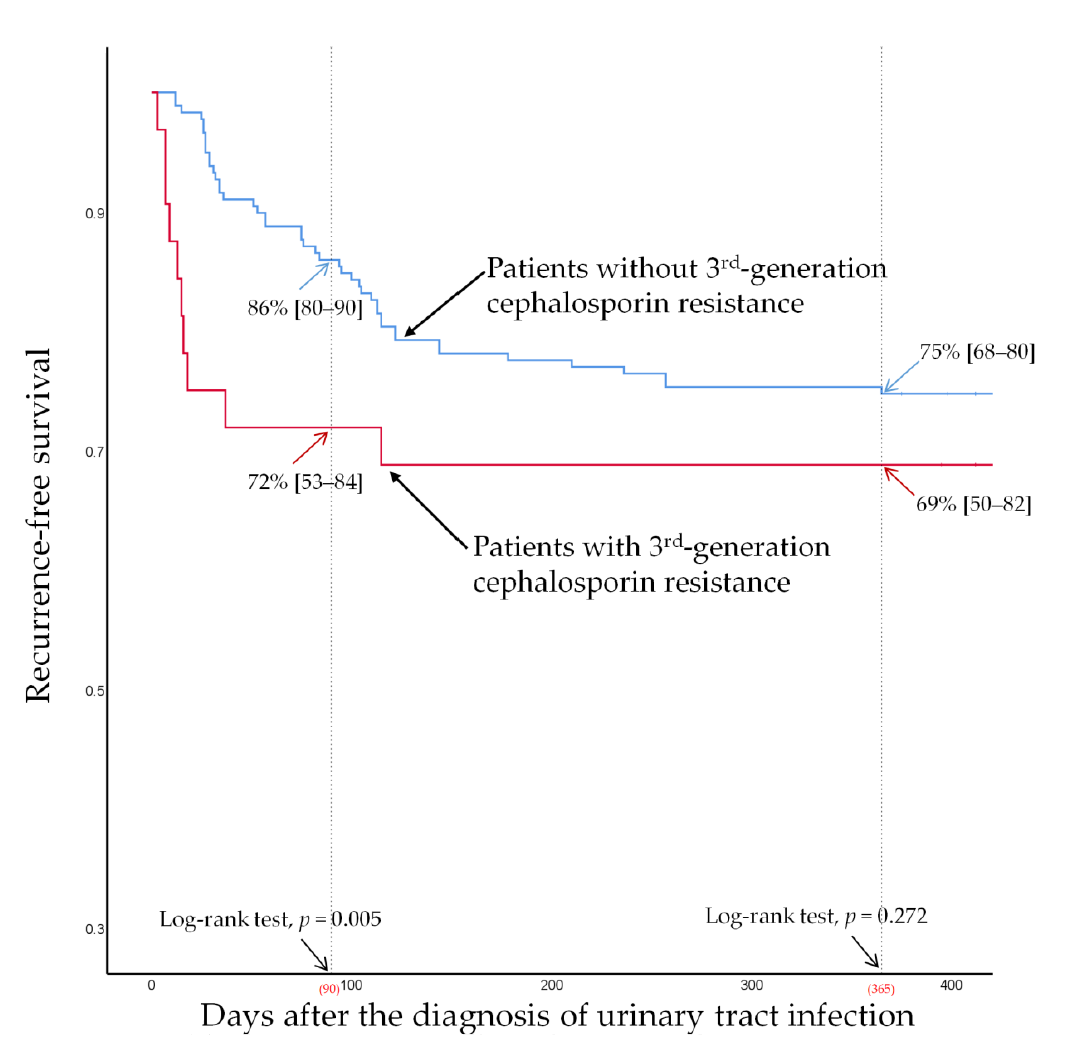
Figure 4. Recurrence-free survival for patients with or without third-generation cephalosporin